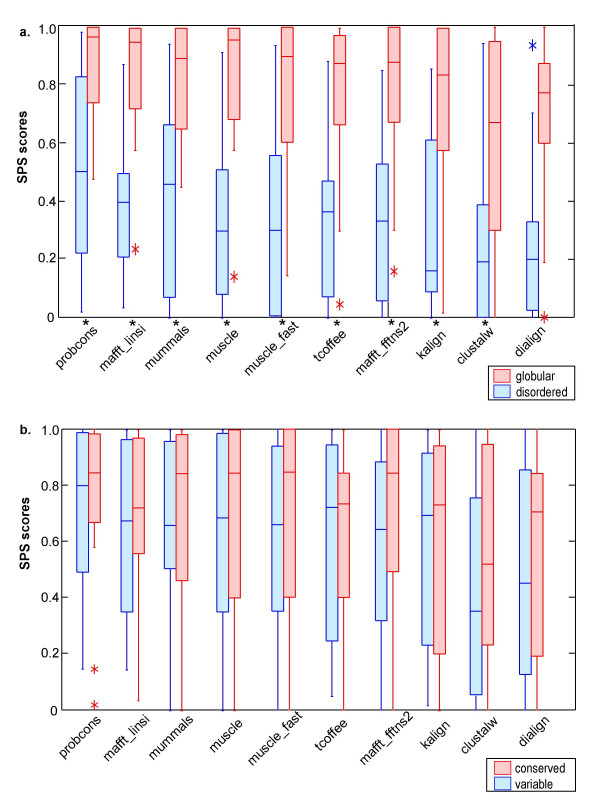
Program SPS scores depending on different motif characteristics. Box plots of the SPS scores obtained by the different alignment programs in subset 1, group V11 (<20% identity) under different conditions. The boxplots indicate the extreme observations (stars), lower quartile, median, upper quartile, and largest observation. Significant differences, according to a Wilcoxon signed ranks test (p < 0.05), are indicated by an asterix on the x-axis. P-values for the Wilcoxon tests are available in additional file 1, table 2. a) SPS scores for motifs found in globular domains versus disordered regions. b) SPS scores for motifs with a conserved residue versus variable motifs.